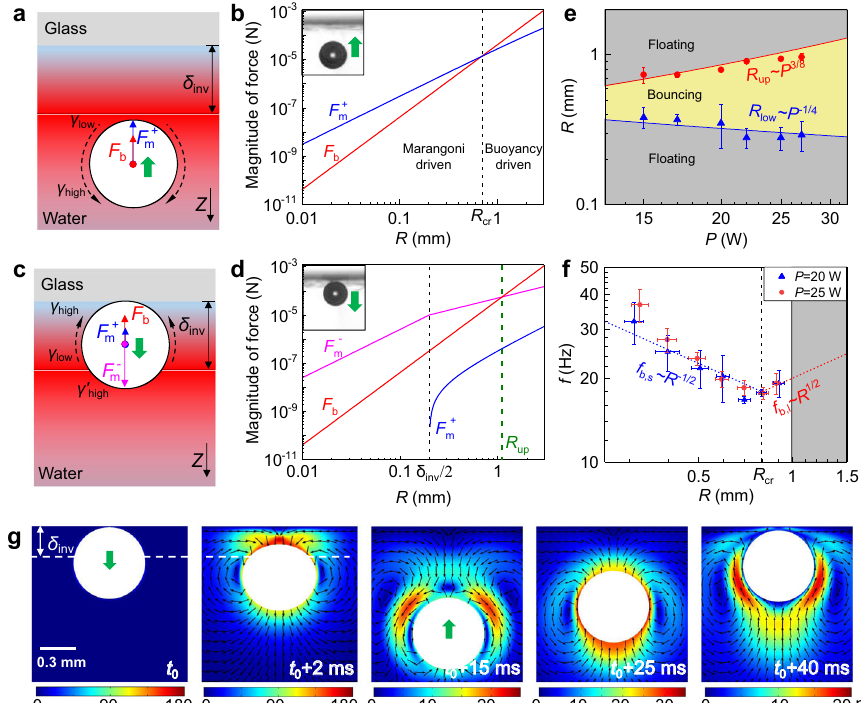
Fig. 3 | Mechanism of the bubble bouncing. a – d The relevant driving force responsibleforthe bouncing at P =20W. Sketchof the competing buoyancy force and the thermal Marangoni force, and their magnitudes dependent on bubble radius, when bubble moves in liquid ( a , b ) and rests near the wall ( c , d ), respec- tively. e The lower ( R low ) and upper bound ( R up ) for the bouncing behavior dependent on the laser power ( P ), the lines for theory, and dots for the